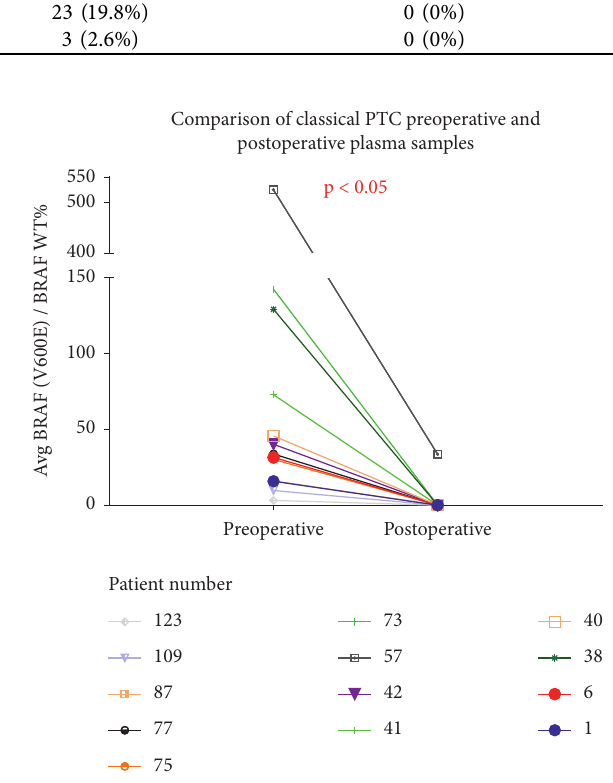
Figure 2: BRAF (V600E) ctDNA detection preoperatively and postoperatively in patients with classical PTC pathology. ∗ 13/38 (31.6%) patients had detectable levels preoperatively, and all de- clined postoperatively. ∗ Those patients with detectable levels of BRAF (V600E) ctDNA are shown. Table 3: Concordance between index nodule FFPE pathology and BRAF (V600E)